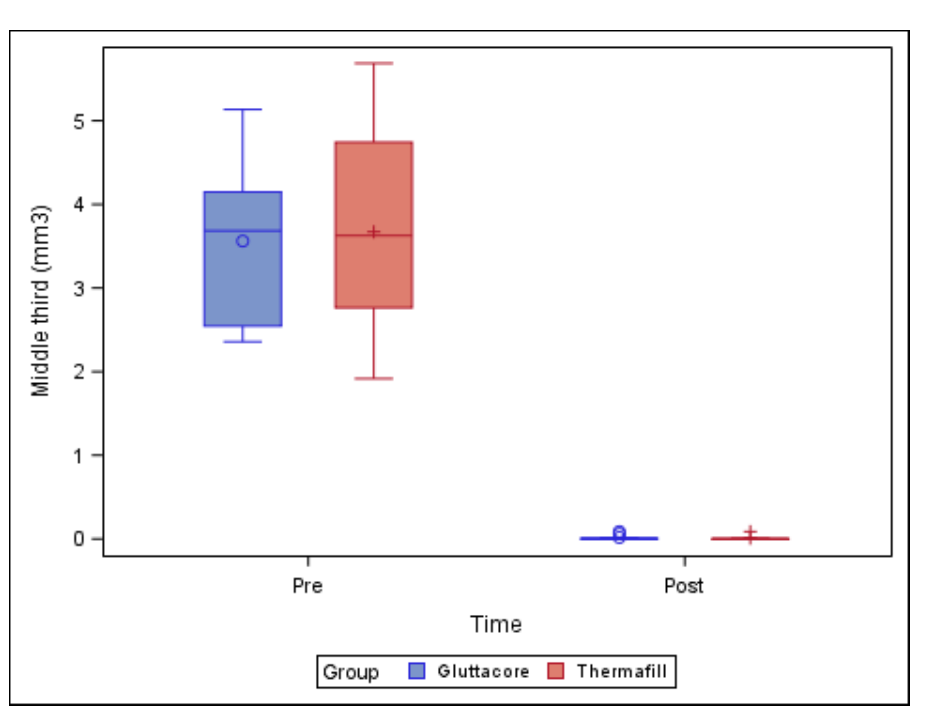
Table 3. Descriptive analysis of the pre-operative root canal filling material volume (mm 3 ) and the remaining post-operative root canal filling material volume (mm 3 ) at the apical third of the root canal systems.